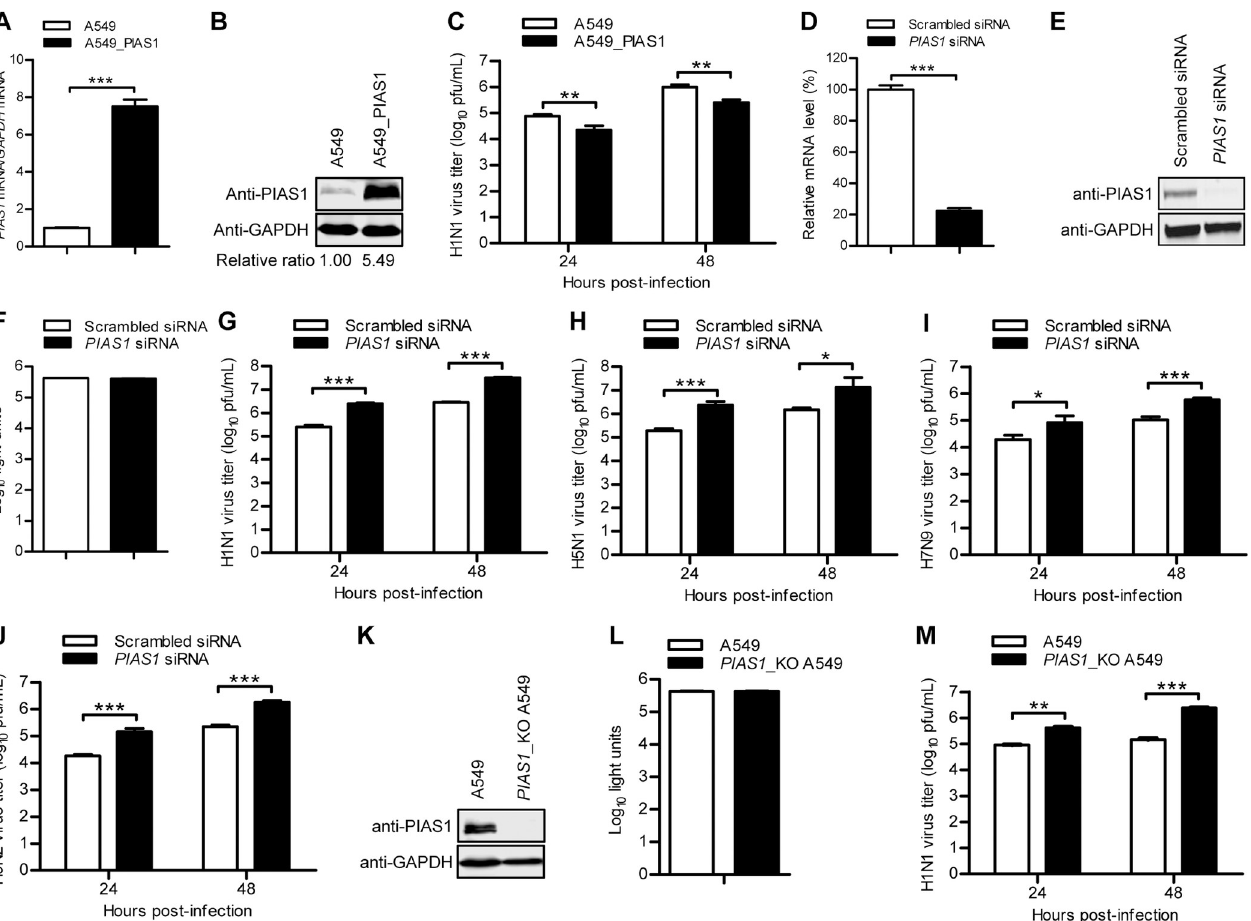
Fig 2. PIAS1 restricts IAV replication in vitro. (A, B) Establishment of a lentiviral-mediated PIAS1-overexpressing A549 cell line. The stable expression of PIAS1 was confirmed by quantitative reverse transcription PCR (RT-qPCR) (A) and western blotting with a rabbit anti-PIAS1 pAb (B). ��� , P < 0.001. (C) The PIAS1-overexpressing or control A549 cells were infected with WSN (H1N1) virus (MOI = 0.01). Supernatants were collected at the indicated timepoints, and virus titers were determined by means of plaque assays on MDCK cells. �� , P < 0.01. (D, E) siRNA knockdown of PIAS1 in A549 cells. A549 cells were transfected with siRNA targeting PIAS1 or with scrambled siRNA for 48 h. Cell lysates were subjected to RT-qPCR (D) or western blotting with a rabbit anti- PIAS1 pAb (E) to confirm the downregulation of PIAS1. ��� , P < 0.001. (F) Cell viability of siRNA-treated A549 cells as in (D, E) was determined by using a CellTiter-Glo assay. (G to J) Virus replication in siRNA-treated A549 cells as in (D, E). PIAS1 siRNA- or scrambled siRNA-transfected A549 cells were infected with WSN (H1N1) (MOI = 0.01) (G), AH05 (H5N1) (MOI = 0.1) (H), AH13 (H7N9) (MOI = 0.1) (I), or SH13 (H9N2) (MOI = 0.1) (J) virus. Supernatants were collected at the indicated timepoints, and virus titers were determined by means of plaque assays on MDCK cells. � , P < 0.05, ��� , P < 0.001. (K) Knockout of PIAS1 in PIAS1 _KO A549 cells was confirmed by western blotting with a rabbit anti-PIAS1 pAb. (L) Cell viability of PIAS1 _KO A549 cells was determined by using the CellTiter-Glo assay. (M) Virus replication in PIAS1 _KO A549 cells. PIAS1 _KO or control A549 cells were infected with WSN (H1N1) (MOI = 0.01) virus. Supernatants were collected at the indicated timepoints, and virus titers were determined by means of plaque assays on MDCK cells. �� , P < 0.01, ��� , P <